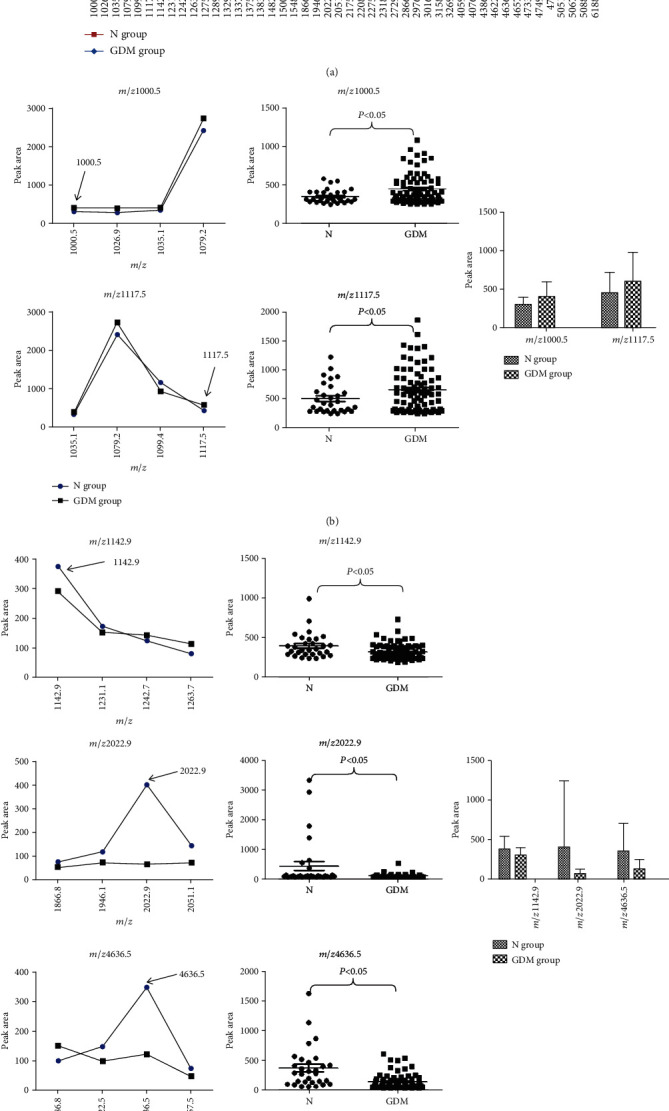
Urine polypeptides in the N group and the GDM group were analyzed. The samples in the N and GDM groups were urine samples of 30 normal pregnant women and 78 GDM patients, respectively. (a) The average peak area distributions of all polypeptide peaks were measured in two groups. Five urine polypeptides which were indicated by the arrow were statistically significant in the comparative analysis of two groups (P < 0.05). (b) In the comparative analysis of five polypeptides between the N and GDM groups, there were significant differences in the m/z 1000.5 and 1117.5 (left, P < 0.05). The distributions of two polypeptides in two groups are shown (middle). The peak value of two polypeptides in the GDM group was higher than that in the N group (right, P < 0.05). (c) There were significant differences in the m/z 1142.9, 2022.9, and 4636.5 (left, P < 0.05). The distributions of three polypeptides in two groups are shown (middle). The peak value of three polypeptides in the GDM group was lower than that in the N group (right, P < 0.05).